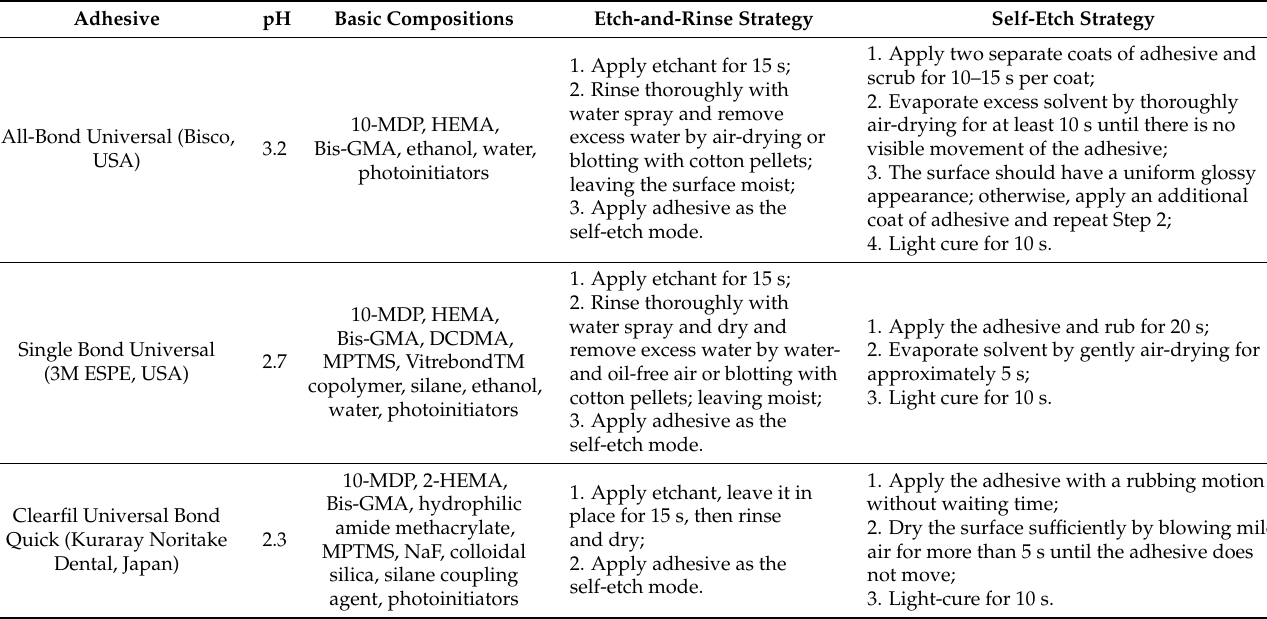
Table 1. Composition and application protocols of universal adhesives with etch-and-rinse and self-etch mode according to the manufacturer’s